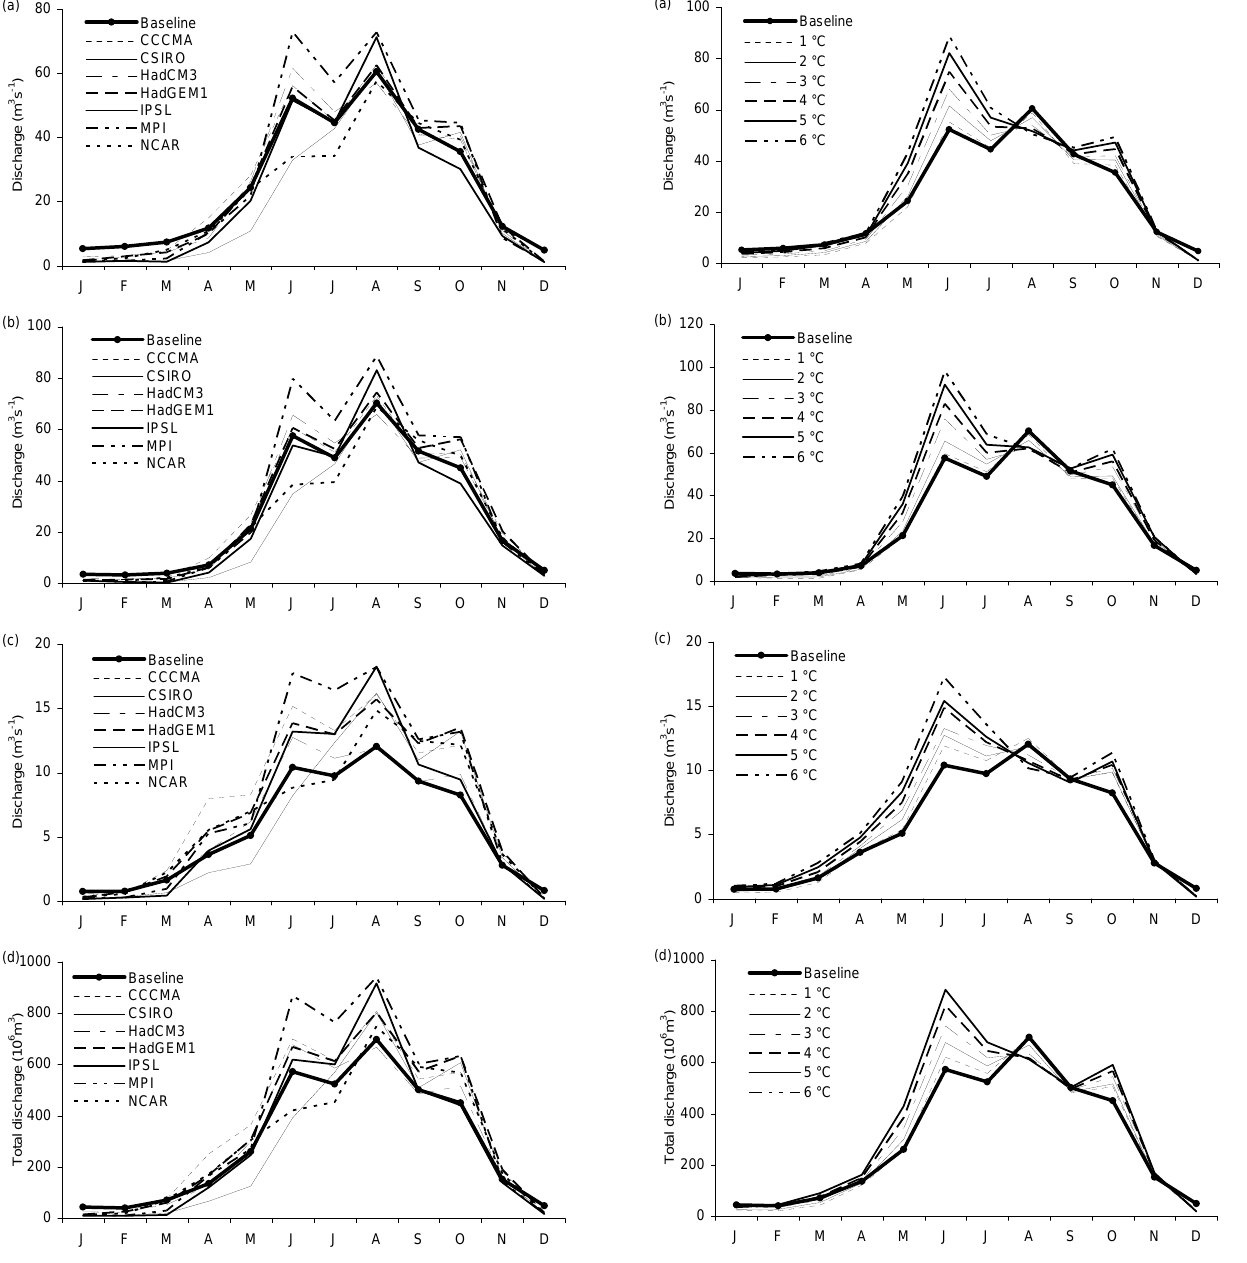
shown in Table 6. The CSIRO GCM results in an overall decline in annual river flow to the lake with the noticeable reduction in early monsoon flows and higher flows in Au- gust. However, the magnitude of this decline is only 6% de- spite the larger reductions in flow reported above for the Iril and Thoubal sub-catchments (15% and 20%